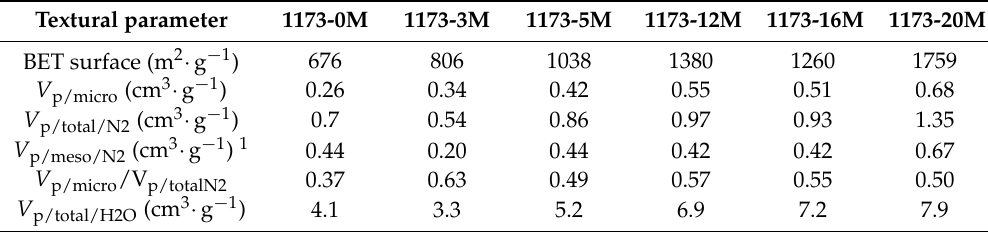
Table 3. Textural data of carbons obtained from char carbonized at 1173